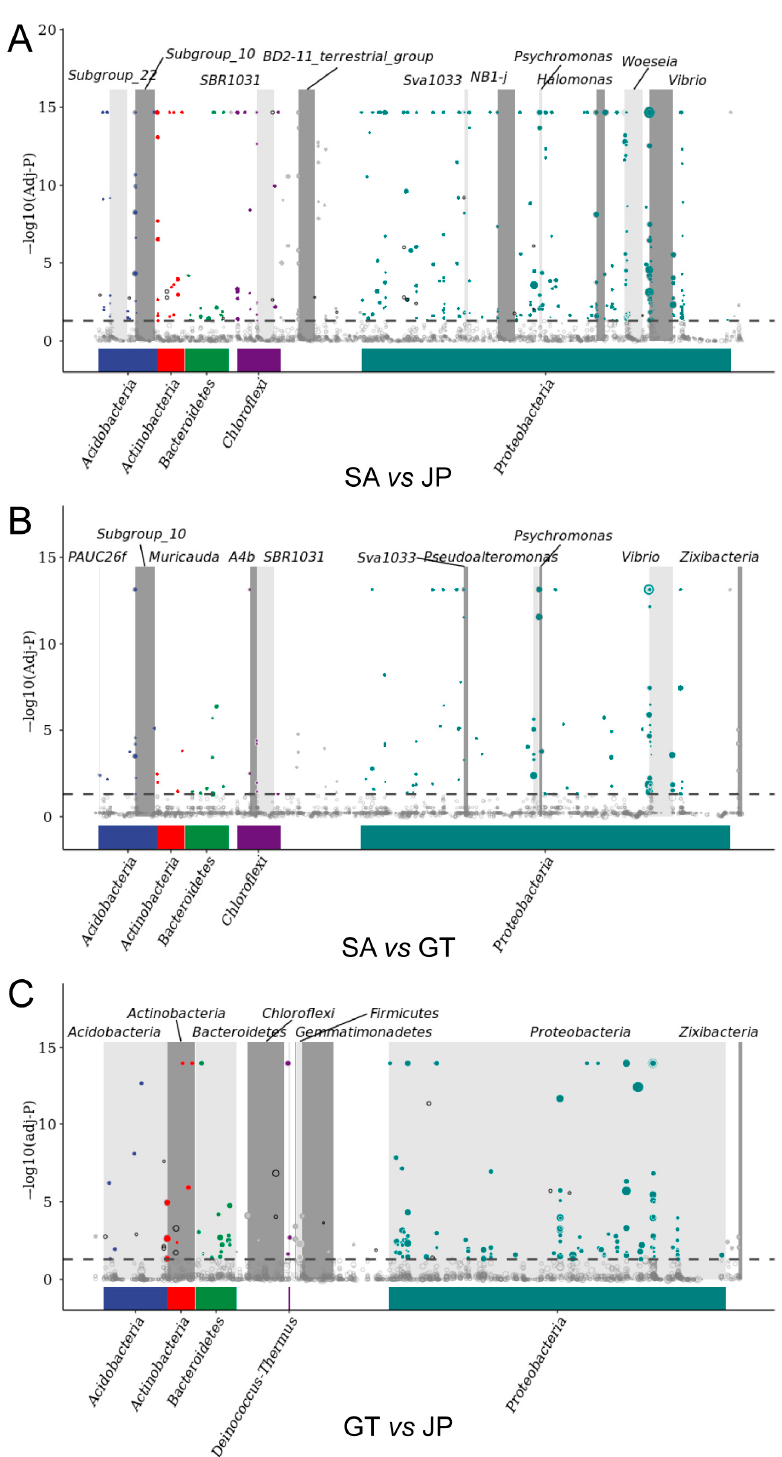
Figure 5. MetagenomeSeq analysis looked for significant differences in species composition between bare flats (GT), Sueada salsa areas (JP), and S. alterniflora Loisel areas (SA). ( A ) Differences in gene expression in bacterial communities between SA and JP. ( B ) Differences in gene expression in bacterial communities between SA and GT. ( C ) Differences in gene expression in bacterial communities between GT and JP. The top icon shows the most distinct phylum. The color of the points represents the phylum to which it belongs, which is consistent with the color of the phylum below